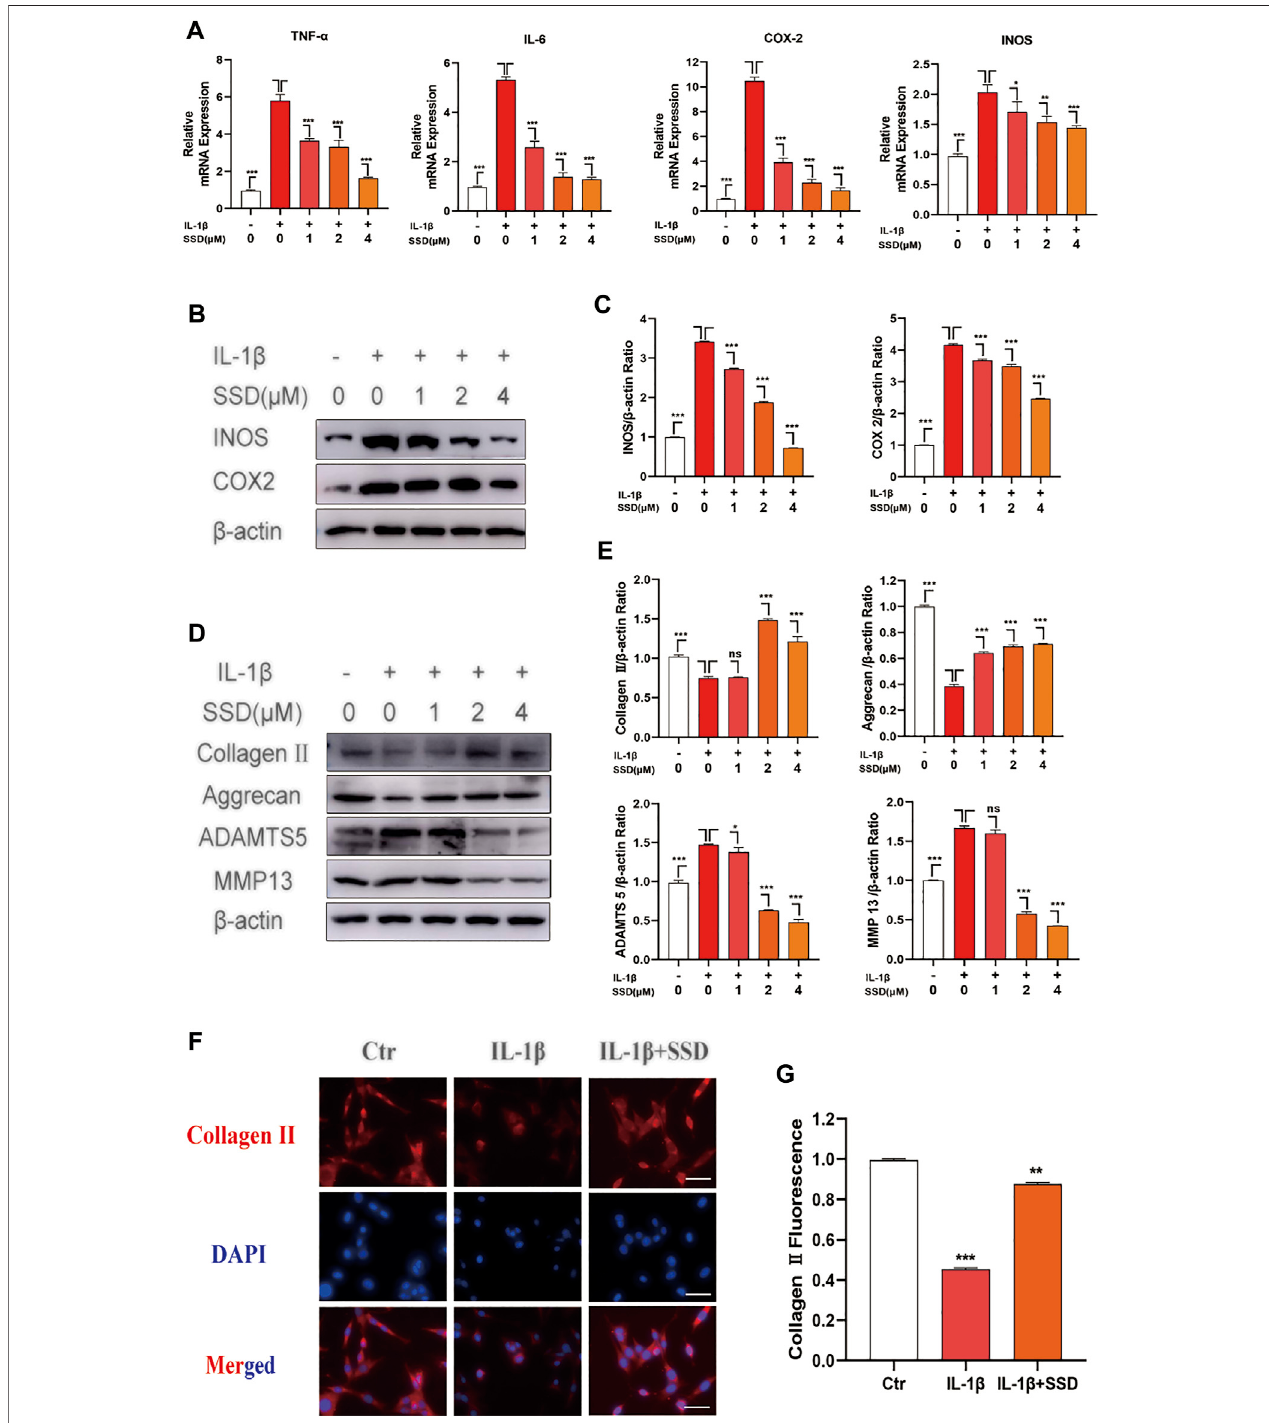
FIGURE 3 | SSD attenuated the production of in fl ammation-related factors and protected the ECM from damage under the stimulation of IL-1 β . The mature chondrocytesstimulatedby10 ng/mlIL-1 β ornotwereincubatedwithdifferentconcentrationsofSSD(0,1,2,and4 μ M)for2 days.TheextractedRNAandtotalprotein were used for further analysis by Western blot and qPCR. (A) SSD inhibited the expression level of in fl ammatory cytokine related marker genes in a dose-dependent manner. (B) SSD suppressed the production of INOS and COX2, especially at 4 μ M. (C) The quanti fi cation of INOS and COX2 protein expression levels. (D) SSD reduced the expression level of ADAMTS 5 and MMP13 and increased the expression level of Aggrecan and Collagen II in a dose-dependent manner. (E) The quanti fi cation of ADAMTS 5, MMP13, Aggrecan, and Collagen II protein expression levels. (F) Immuno fl uorescence was conducted to visualize Collagen II. (G) The quanti fi cation of Collagen II fl uorescence intensity (original magni fi cation, ×200; scale, 15 μ m). Mean ± SD was applied with all data. The experiments in vitro were performed independently at least 3 times. *** p < 0.001, ** p < 0.01, * p < 0.05.